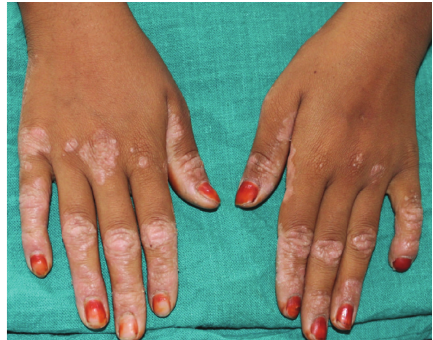
Figure 1: Keratotic plaques over the dorsal surface of the palms.